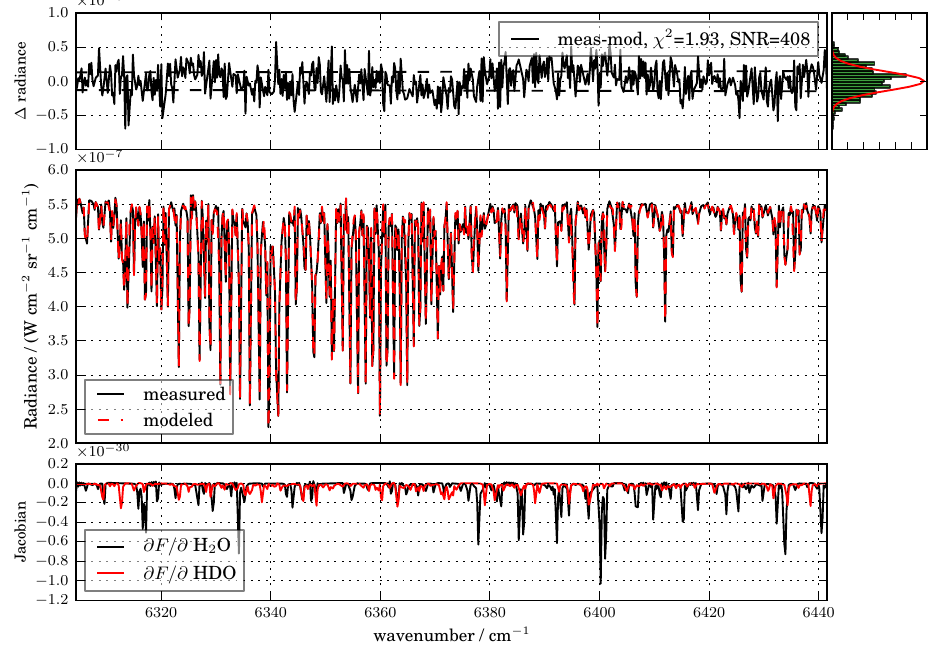
Fig. 1. Center: HDO and H 2 O example fit using GOSAT spectra over Lamont, Oklahoma (black=measured, red=modeled). The upper panel shows spectral residuals (1 σ noise levels indicated by dashed lines). The upper rightmost panel shows the probability density function of observed residuals (black) and the expected distribution based on GOSAT noise estimates (red). The lowest panel shows Jacobians of the radiance F with respect to the HDO and H 2 O column